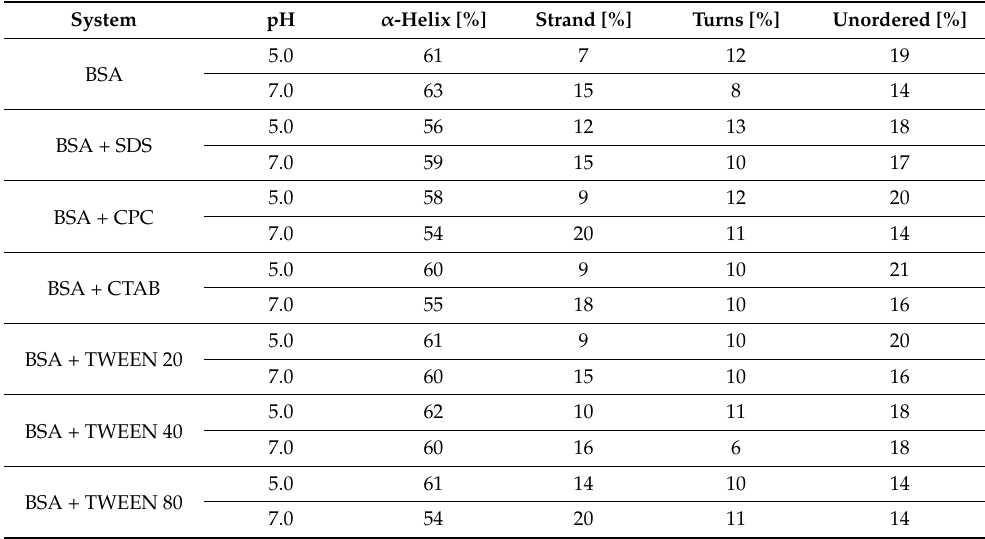
Table 3. The secondary structure content (in %) of BSA in 10 mM CACO buffer of pH 5.0 and 7.0 at 298 K revealed from CD